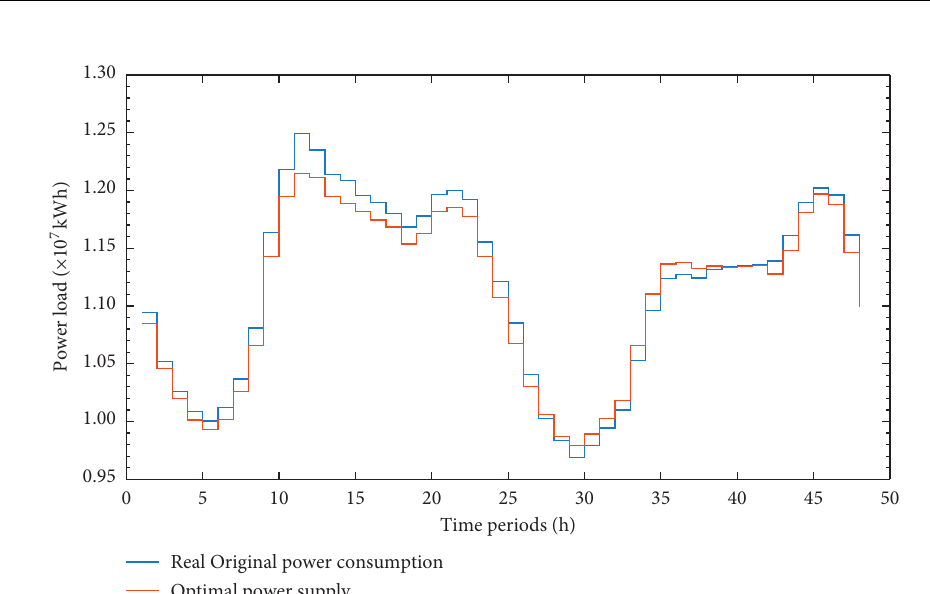
Figure 1: Power load before adjustment (blue lines indicate real original power consumption and red lines denote optimal power